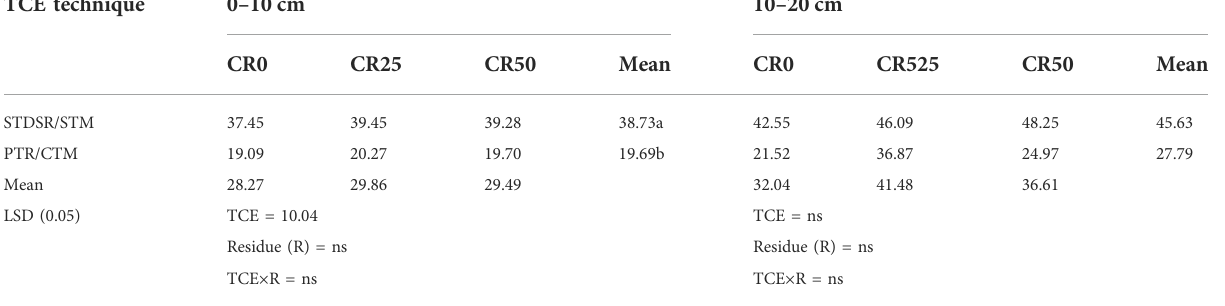
TABLE 4 Quantity of carbon in dissolved organic carbon (DOC) (mg kg − 1